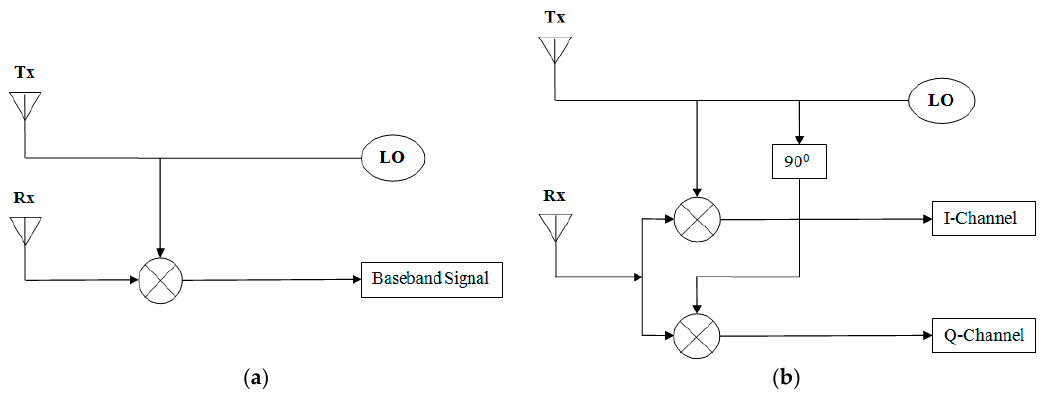
Figure 3. ( a ) Single-channel architecture; ( b ) Quadrature architecture.